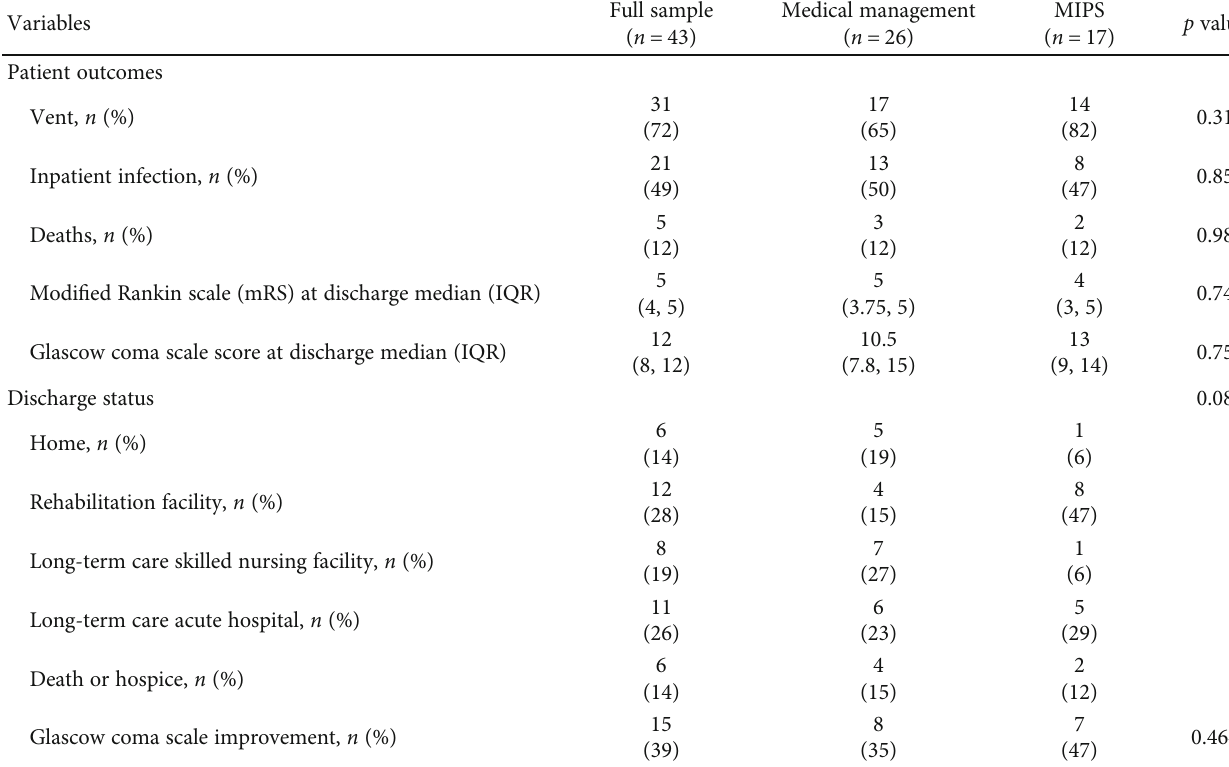
Table 2: Outcome data for the full sample and by treatment group: medical management versus minimally invasive parafascicular surgery (MIPS).